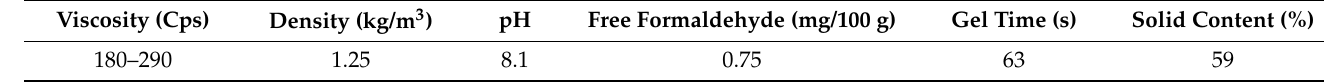
Table 1. Physical and chemical properties of urea-formaldehyde.